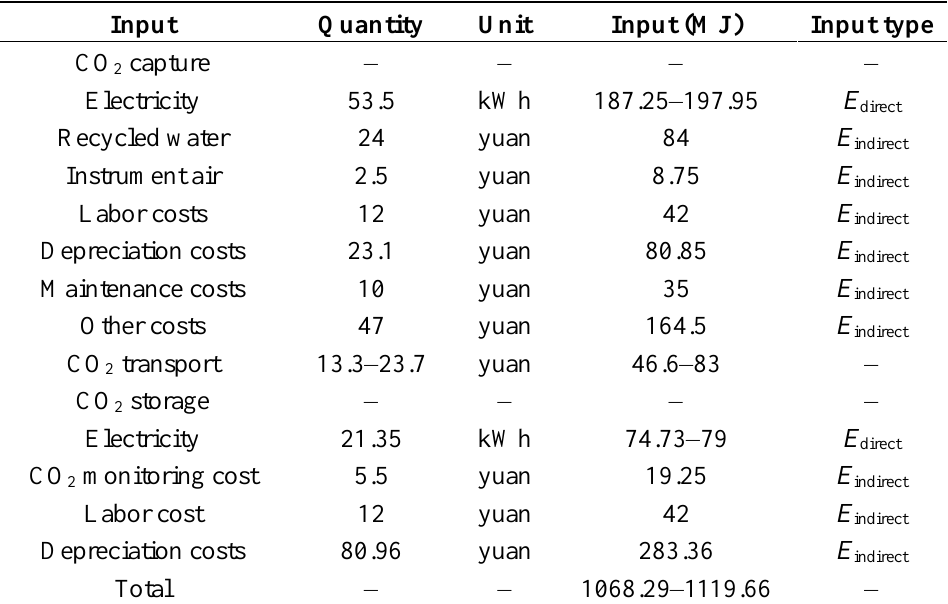
Table 6. Costs of CCS per t CO 2 and our conversion to MJ.